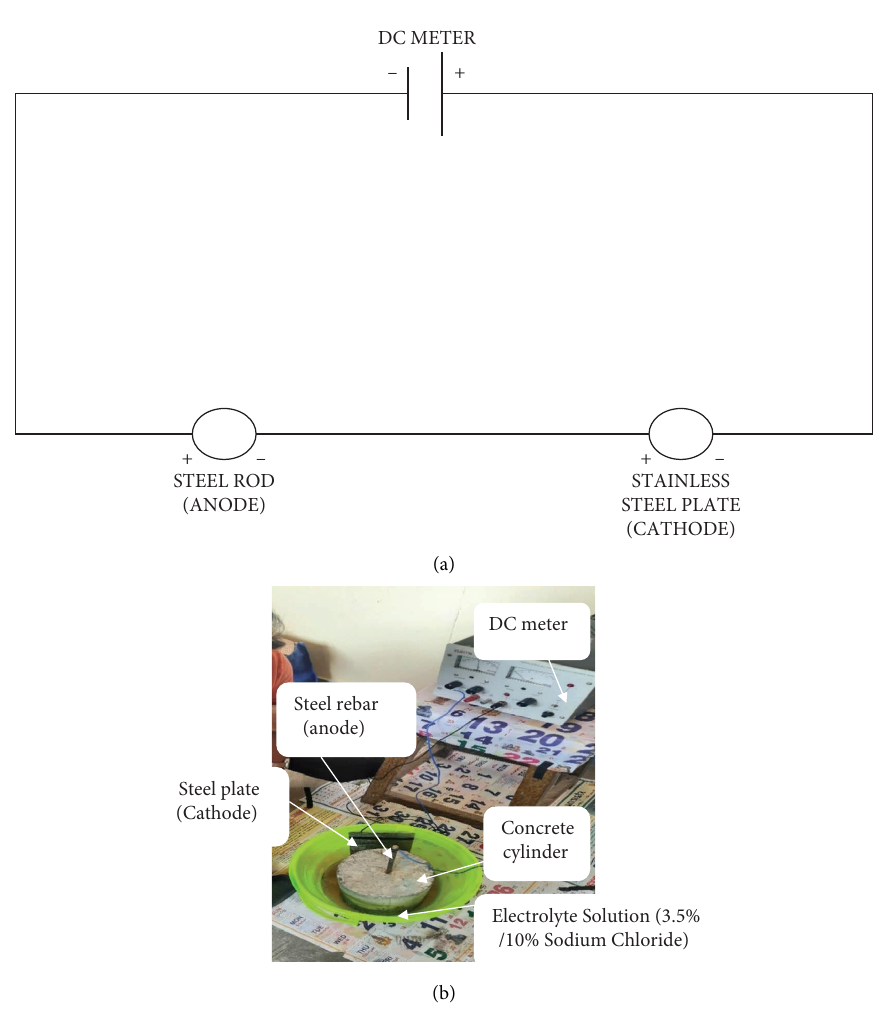
Figure 4: Accelerated corrosion test. (a) Schematic representation of electrical layout and (b) test